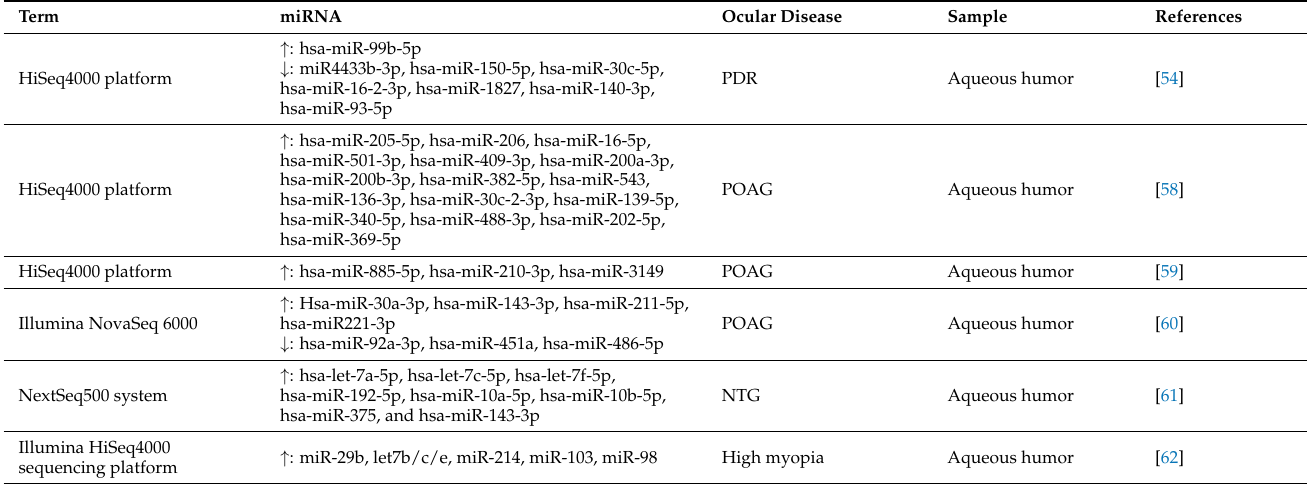
Table 2. Differentially expressed miRNAs in intraocular diseases identified by high-through- put